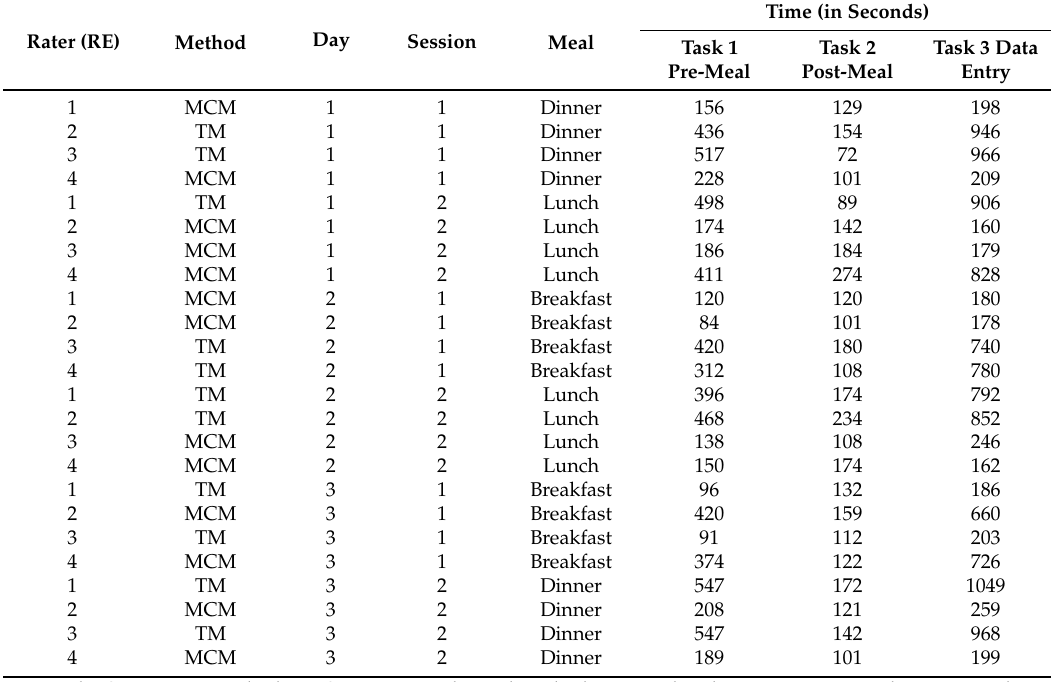
Table 2. Assignment matrix and times for the time savings